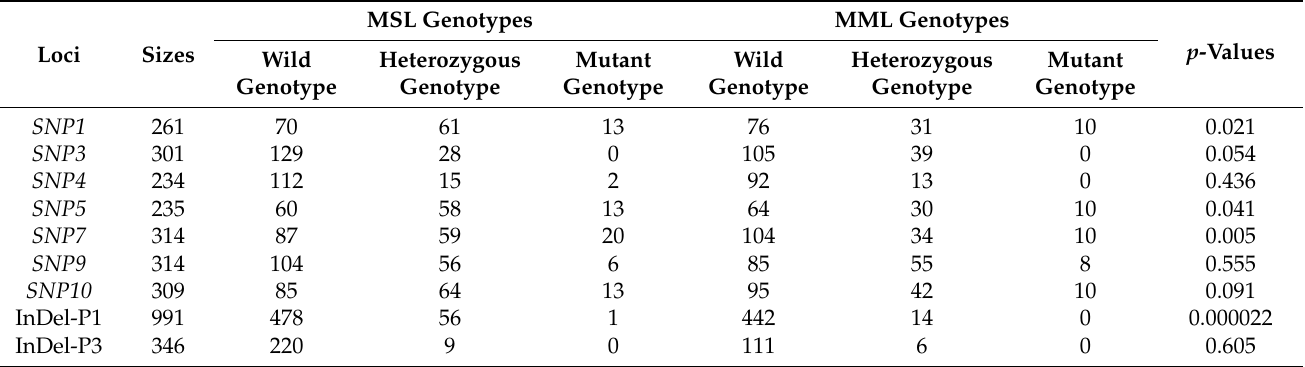
Table 3. Genotype Distribution of DNAH1 Gene Indel Mutations between Mothers of Single Kids and Multiple Kids in Shaanbei White Cashmere Goat.